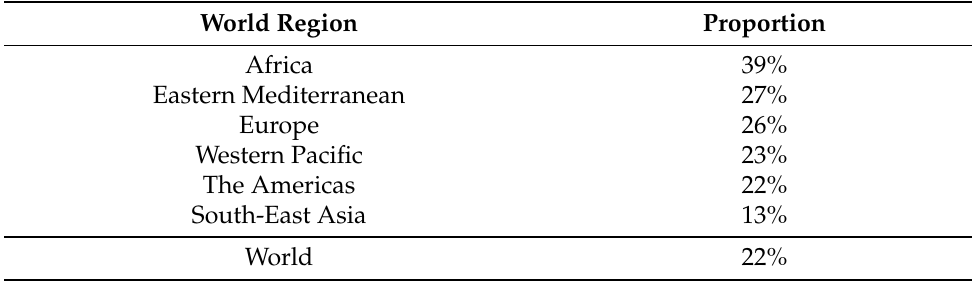
Table 1. Proportion of pedestrian deaths per world region [8].